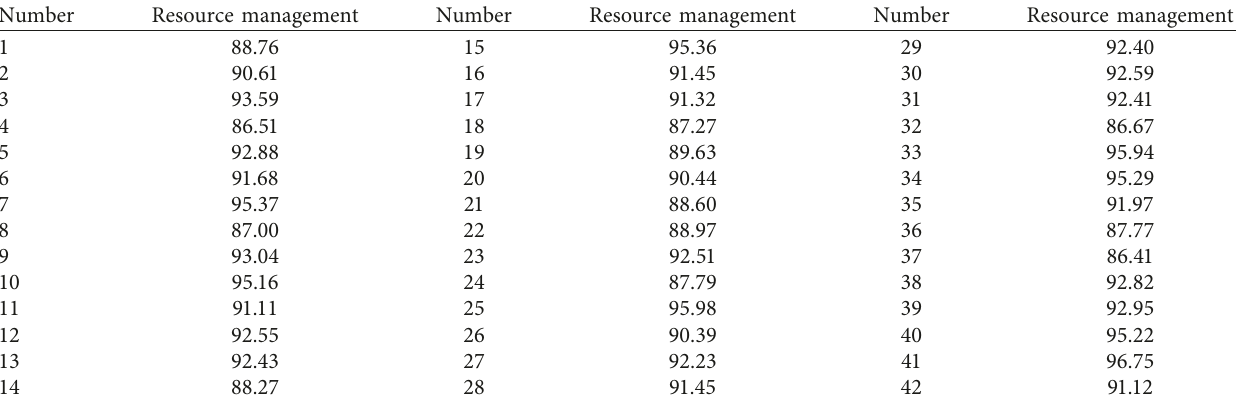
Figure 10: Resource management of digital media art teaching system based on convolutional neural network. (a) Schematic diagram of convolutional layer convolution kernel structure. (b) The overall process of the resource integration method based on the convolutional neural network. Table 1: Resource management effect of digital media art teaching system based on convolutional neural